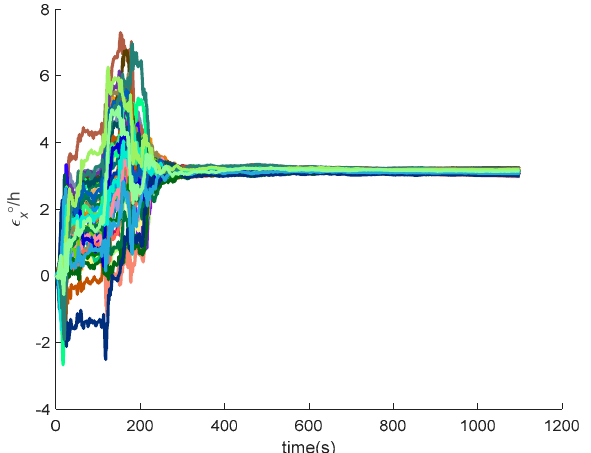
Figure 25. The x -axis gyroscope constant drift of SINS/GPS in the LCEF frame.